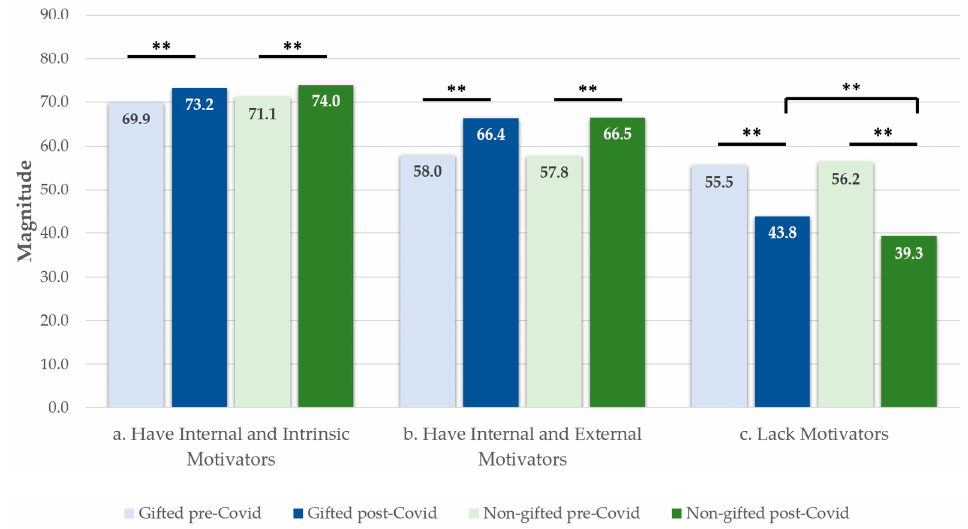
Figure 2. Pre- and post-COVID-19 types of motivators in gifted and non-gifted children (Student’s t -test, ** p < 0.01). The three metrics are represented in the figure. Bars represent values within each study group.